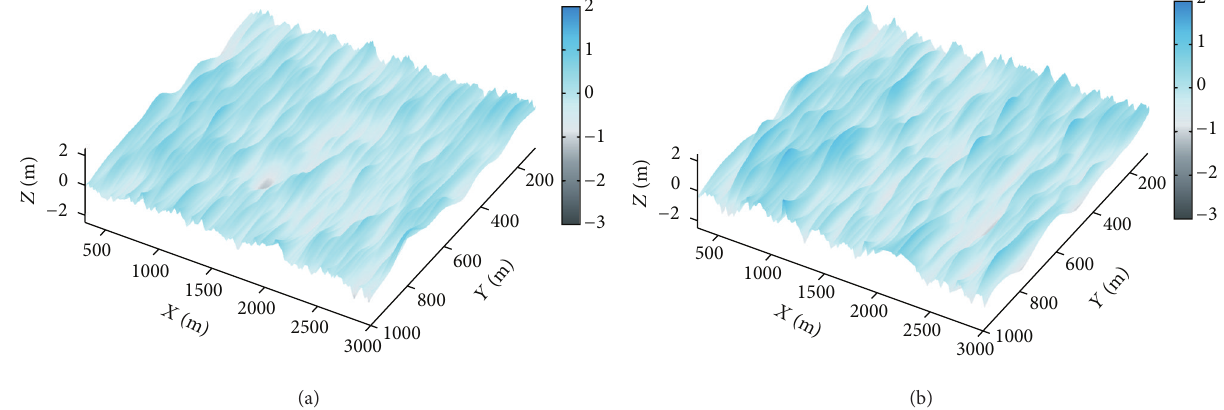
Figure 7: Frozen time frame of the imaged time-varying sea surface based on (a) the primary events of the first shot and (b) the first multiples of the first